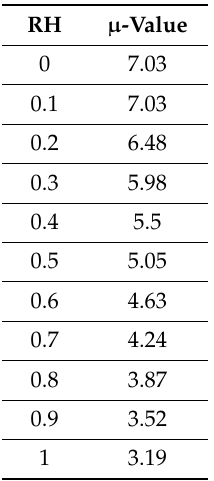
Table A28. Water vapor di ff usion resistance